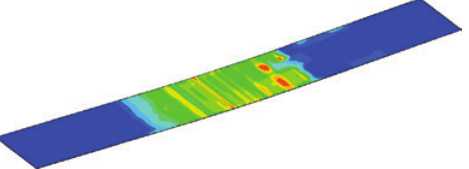
Figure 18: The distribution of plastic strains along the adhesive layer of a CFRP-retrofitted RC beam, as determined using FE analysis after the last cycle, which resulted in debonding of the adhesive layer from the concrete substrate.